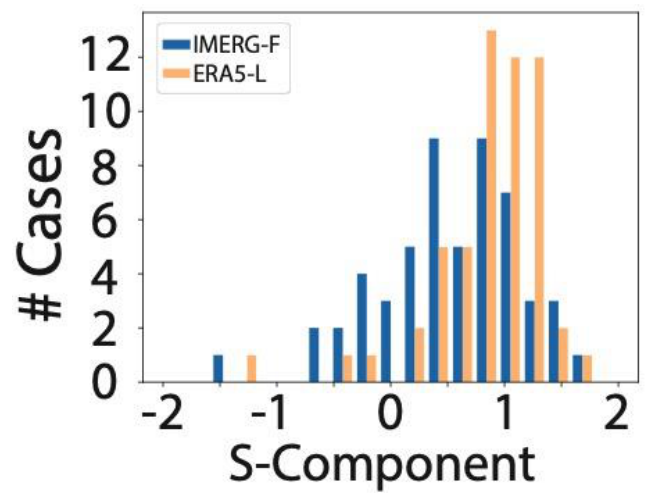
Figure 7. Side-by-side histogram comparing scores of the structure component (S) for IMERG-F and ERA5-L datasets. S evaluates the size and shape of a precipitation field by comparison with the reference data. Results range from −2 to +2. S = 0 means a perfect score and −2 (+2) means underestimation (overestimation).